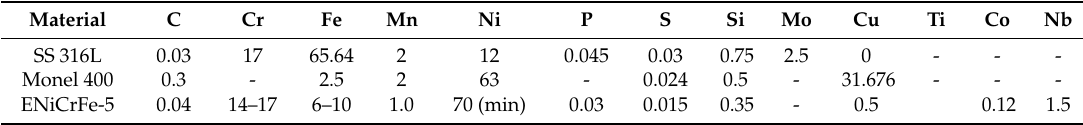
Table 1. Chemical composition of base materials and filler wire.